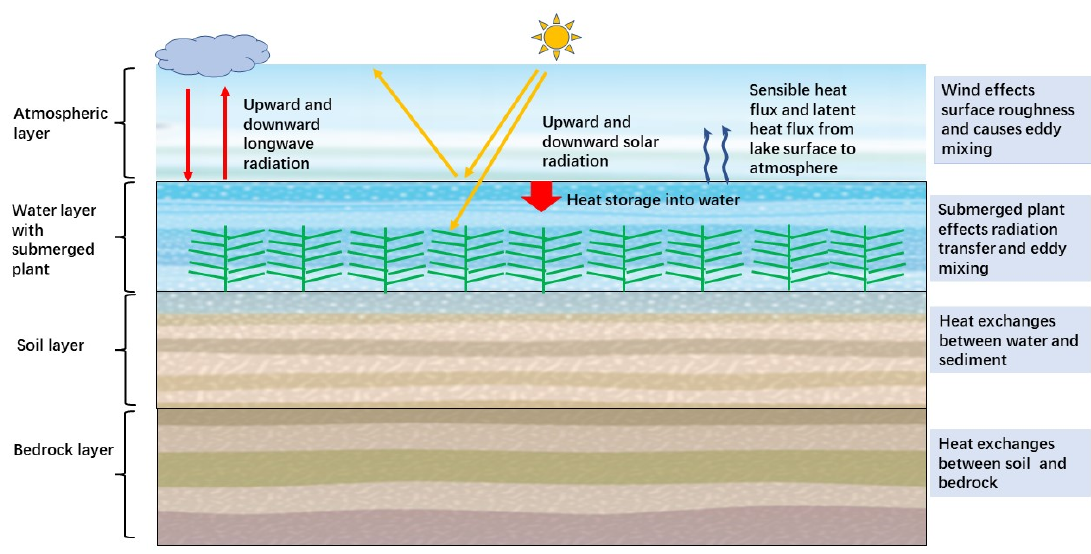
Figure 10. The framework of the proposed lake model.